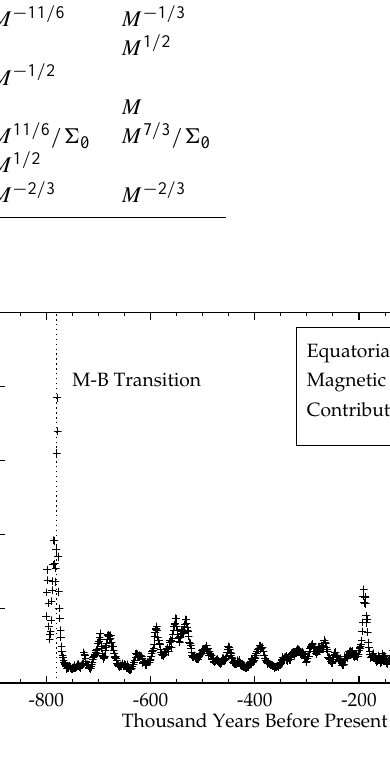
Fig. 5. Estimated relative polar electrojet strength over the past 800000 years.